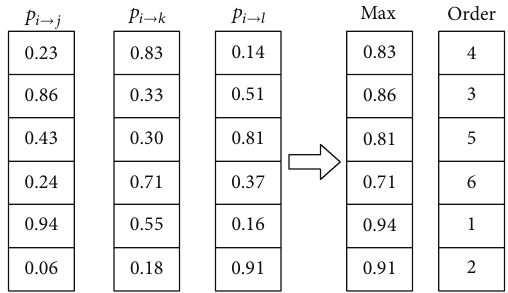
Figure 4: Sketch of the optimal probability selection